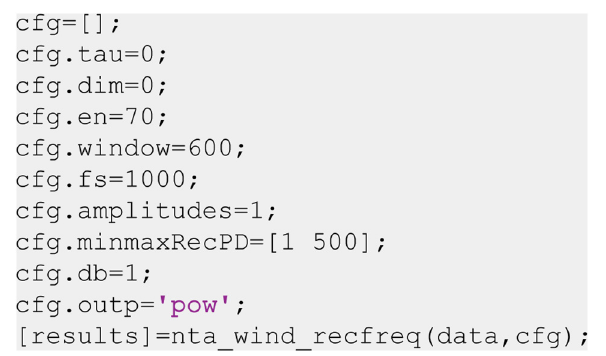
FIGURE 9 | An example script to call nta_wind_recfreq.m. For description of parameters, see Table 1